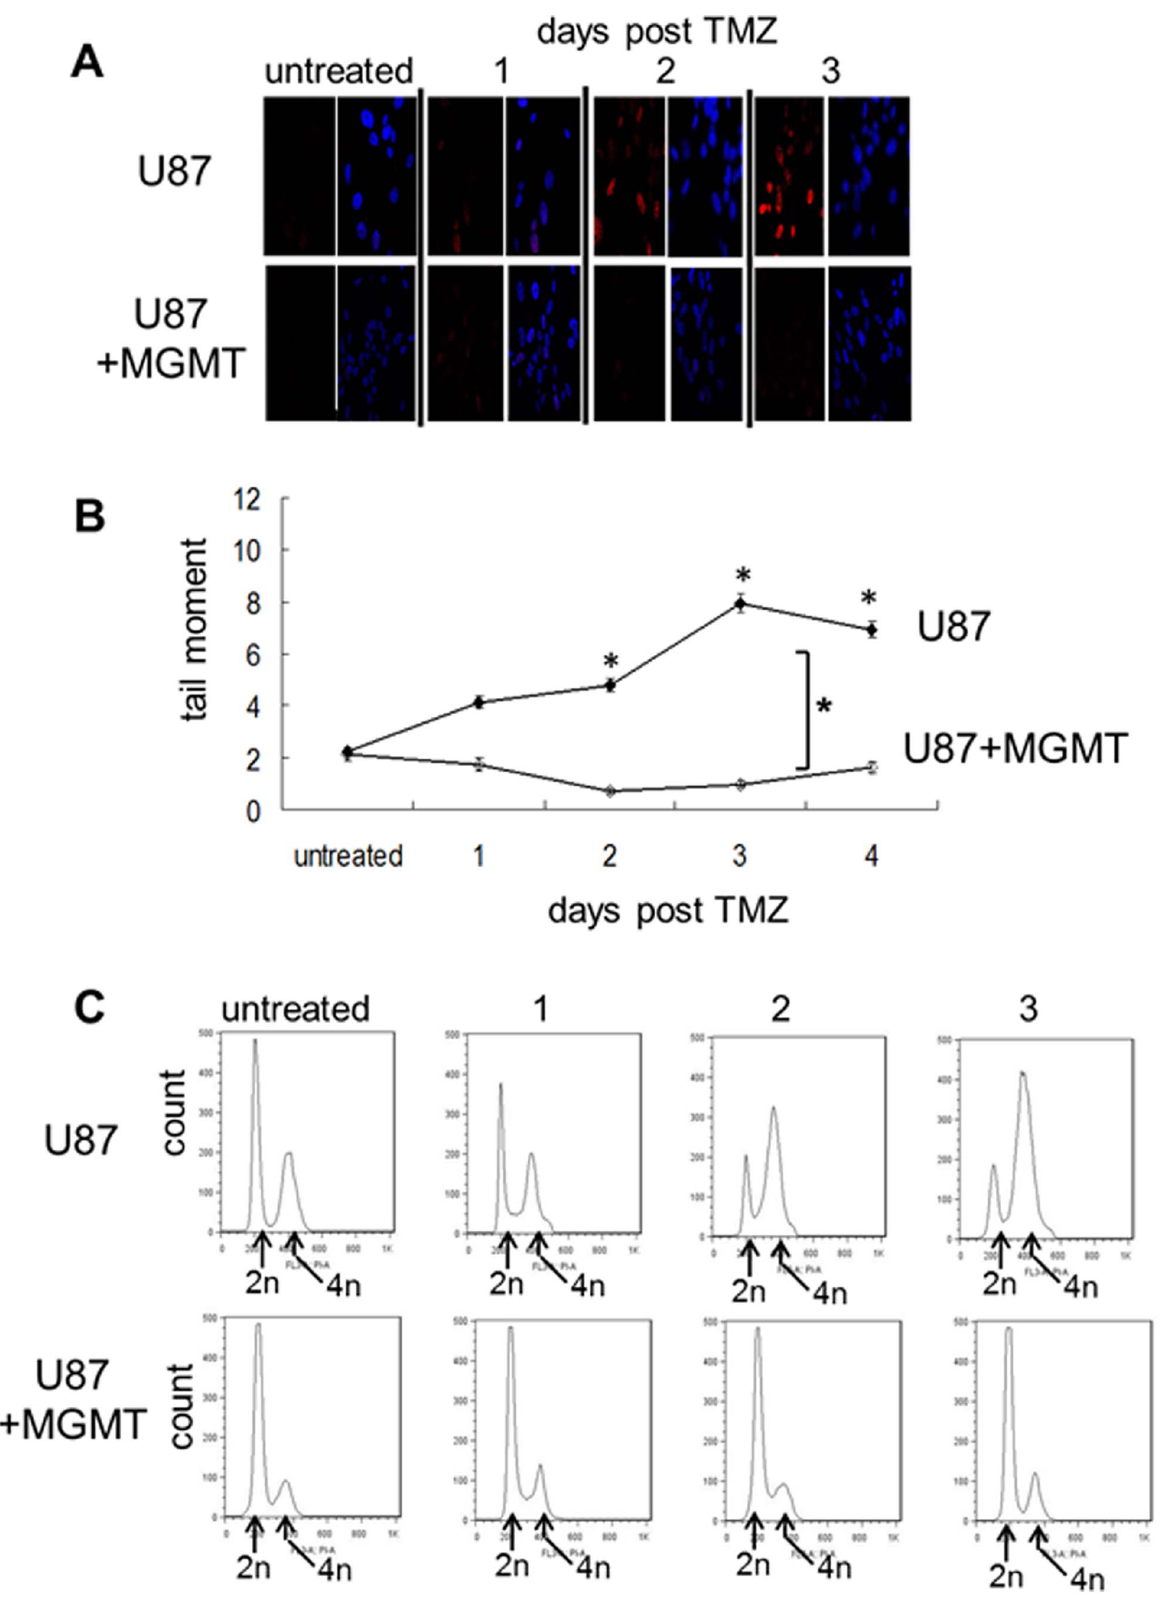
Figure 1. TMZ-induces delayed DNA DSB and cell cycle arrest in an MGMT-dependent manner. MGMT-deficient U87 cells or U87 cells engineered to over-express MGMT (U87 + MGMT) were incubated with vehicle (untreated) or TMZ (100 m mol/L, 3 hours) after which drug was removed and cells were harvested 24, 48, and 72 hours later. A) representative photomicrographs of cells analyzed for phospho-H2A.X foci (a